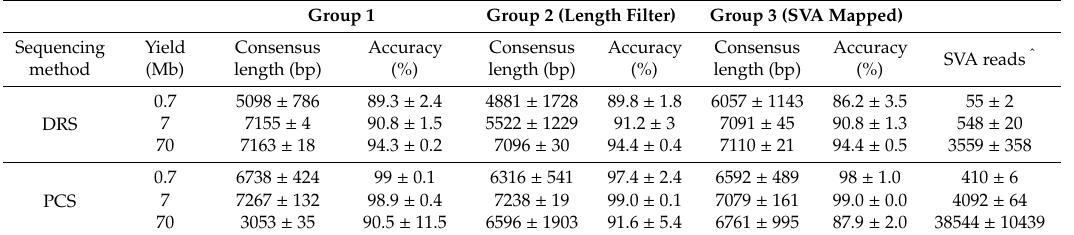
Table 3. Performance of consensus generation using di ff erent raw read filters at di ff erent yields *. Group 1 Group 2 (Length Filter) Group 3 (SVA Mapped) Sequencing Yield Consensus Accuracy method (Mb) length (bp)